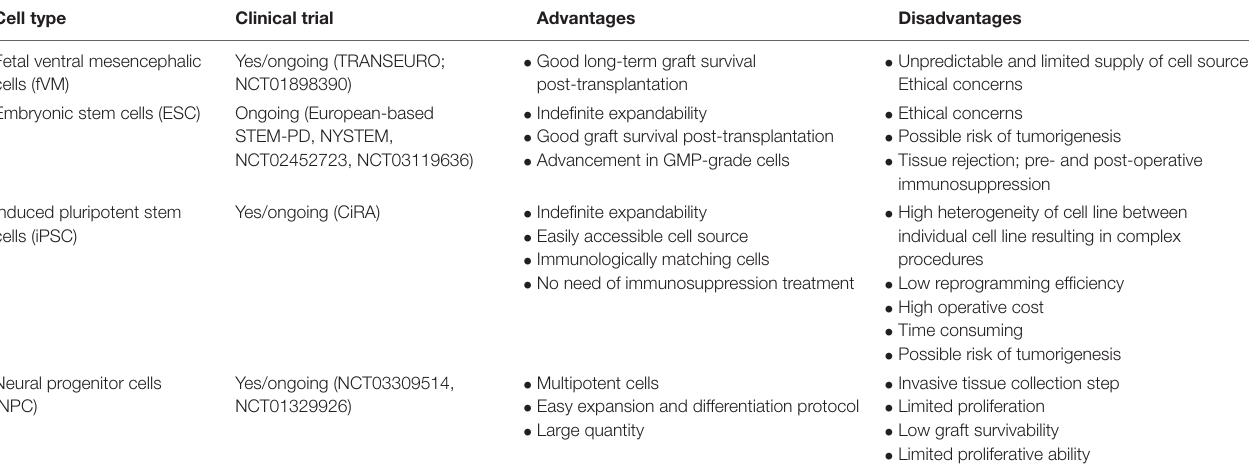
TABLE 1 | Cells used in transplantation for Parkinson’s disease